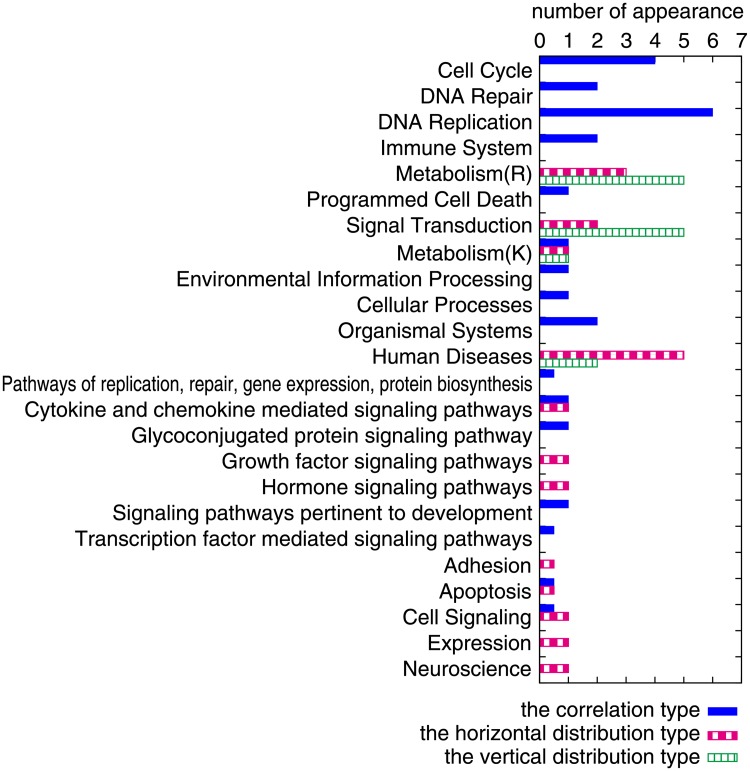
Analysis of pathways of gene functions in three types of scatter diagrams at the 1% level of significance.The number of appearances (X-axis) is shown for each hierarchical framework denoted by the top-class entity (Y-axis). Only the hierarchical frameworks that contain at least one significant pathway are shown from four pathway databases: REACTOME (from Cell Cycle to Signal Transduction), KEGG (from Metabolism(K) to Human Diseases), the Pathway Interaction Database (from Pathways of replication, repair, gene expression, and protein biosynthesis to Transcription factor-mediated signaling pathways), and the BioCarta (from Adhesion to Neuroscience). If a pathway belonged to more than one (np) hierarchical framework, we counted 1/np for each.